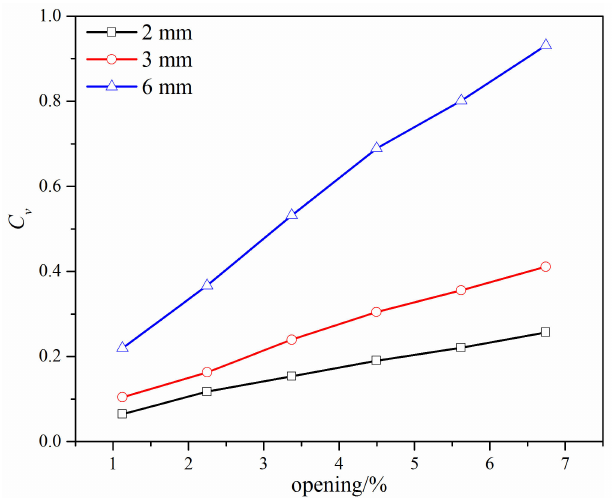
Figure 12. The flow coefficient of the improved V-ball valve with different h values when l = 50